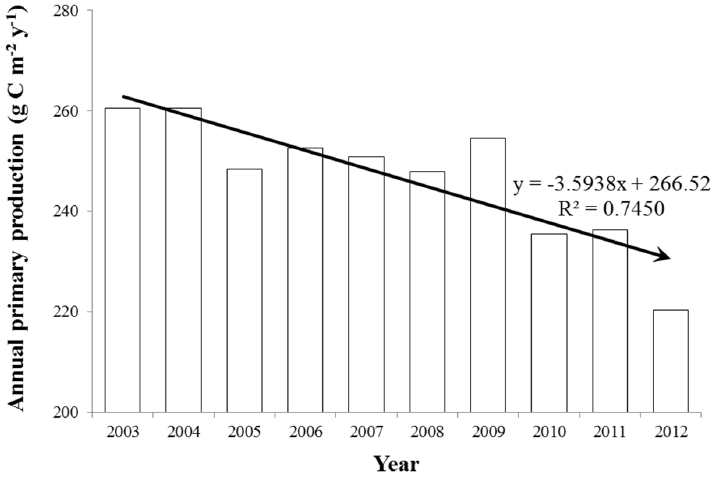
Figure 8. Long-term pattern of annual primary production in the East Sea from 2003 to 2012.